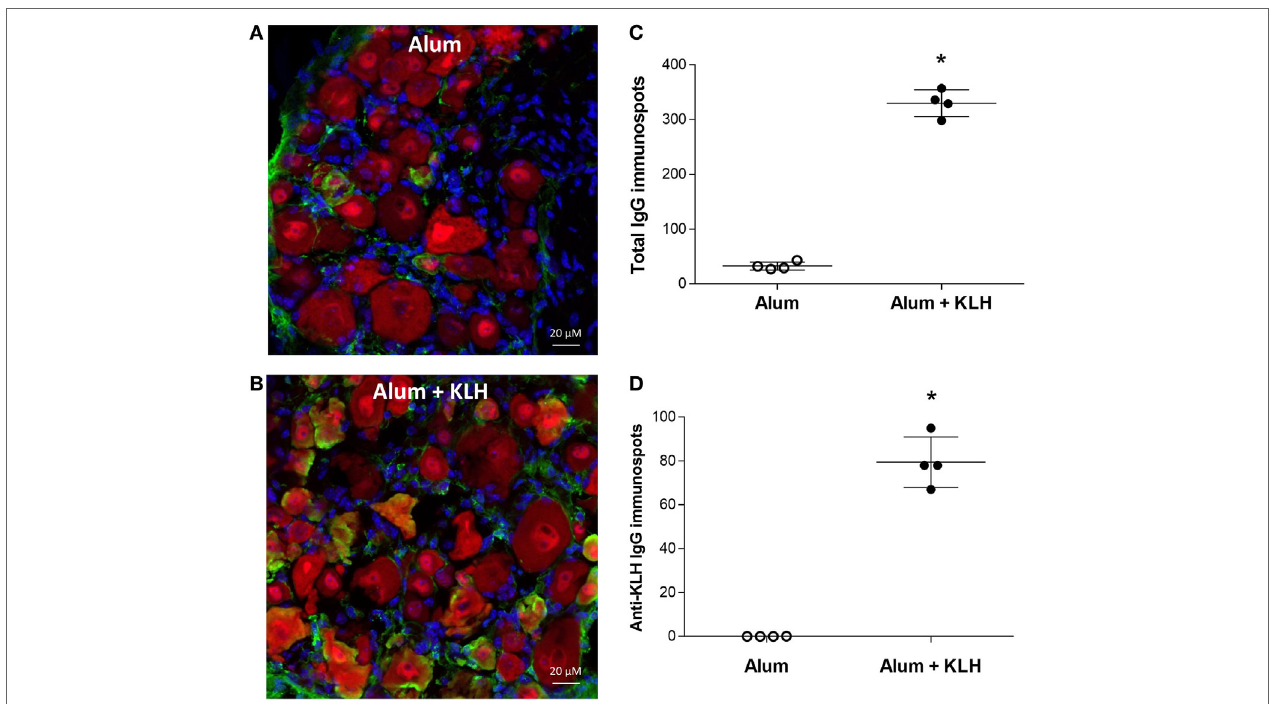
FigUre 5 | Dorsal root ganglion (DRG) neurons from mice lacking neuronal-specific Rag2 expression contain antigen-specific antibodies. Immunohistochemical staining of whole DRGs isolated from alum-injected (a) and alum + KLH-immunized (B) neuronal–specific Rag2 knock-out (KO) mice for IgG (green), neurons (NeuN, red), and nuclei (DAPI, blue). 400 × magnification; scale bar = 20 µm. (c) Quantitation of IgG-releasing DRG neurons isolated from alum-injected and alum + KLH-immunized neuronal-specific Rag2 KO mice using the ELISpot assay (mean ± SD, n = 4 per group); * P < 0.05 vs . alum-injected (Mann-Whitney test). (D) Quantification of anti-KLH-specific IgG immunospots from DRG neurons isolated from alum-injected and alum + KLH-immunized neuronal-specific Rag2 KO mice (mean ± SD, n = 4 per group) using the antigen-specific ELISpot assay * p < 0.05 vs . alum-injected (Mann-Whitney test).